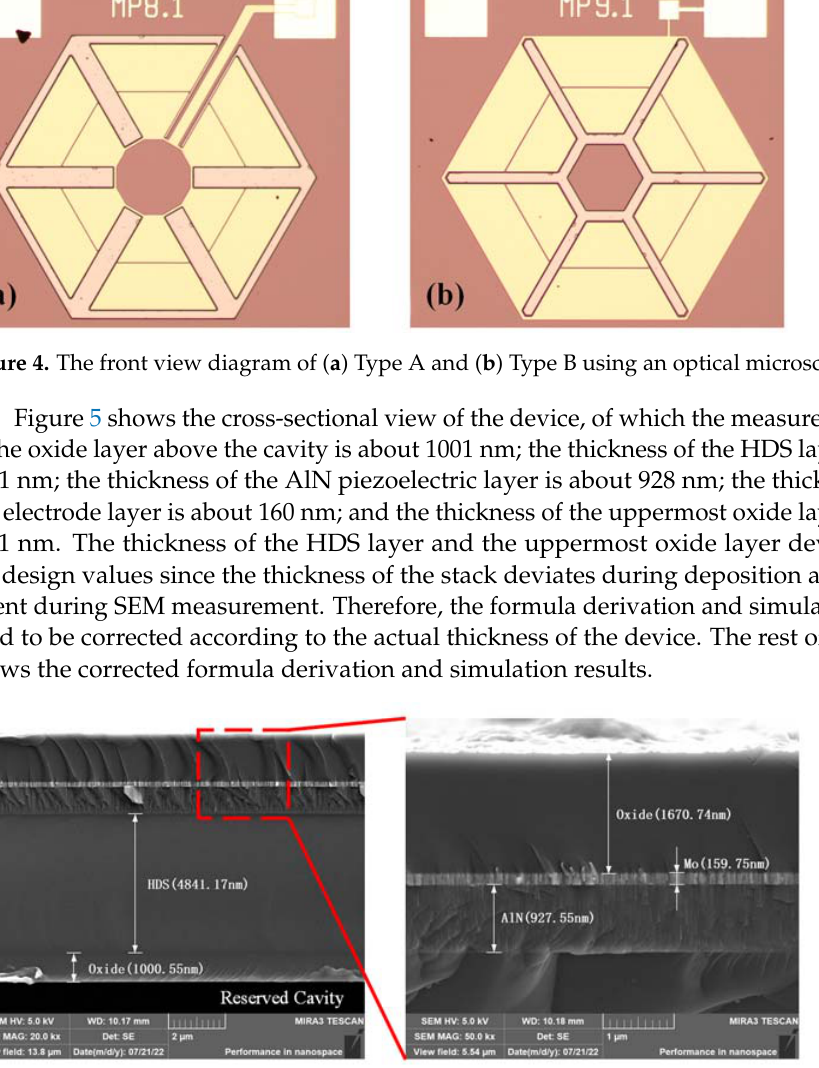
Figure 5. Cross ‐ sectional SEM images of the proposed piezoelectric MEMS accelerometer. Figure 5. Cross-sectional SEM images of the proposed piezoelectric MEMS